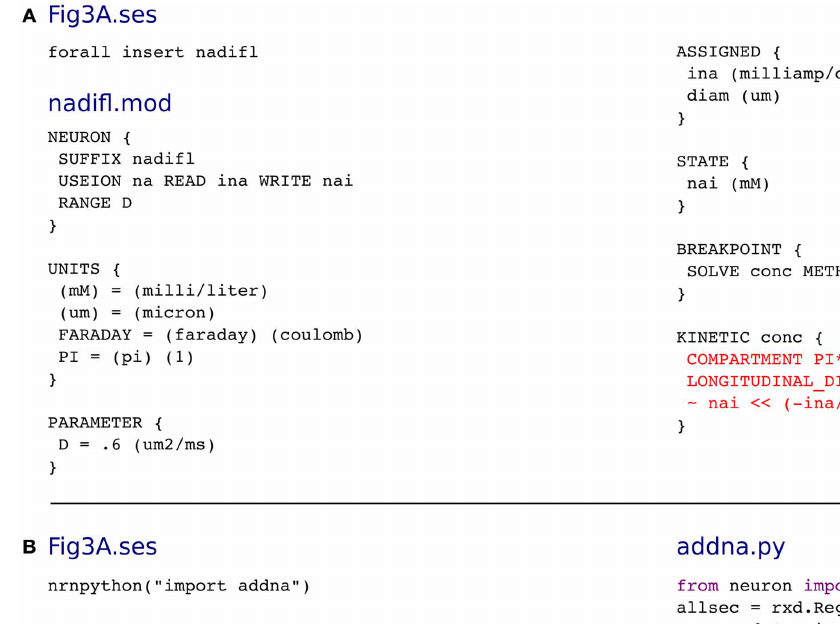
FIGURE 2 | (A) The traditional way of modeling sodium increase due to ion channel activity and diffusion in NEURON, excerpted from the model of Fleidervish et al. (2010). The core of the calculation (red) mixes the geometry and the modeling. To make a fair comparison, Figure 3A.ses has been